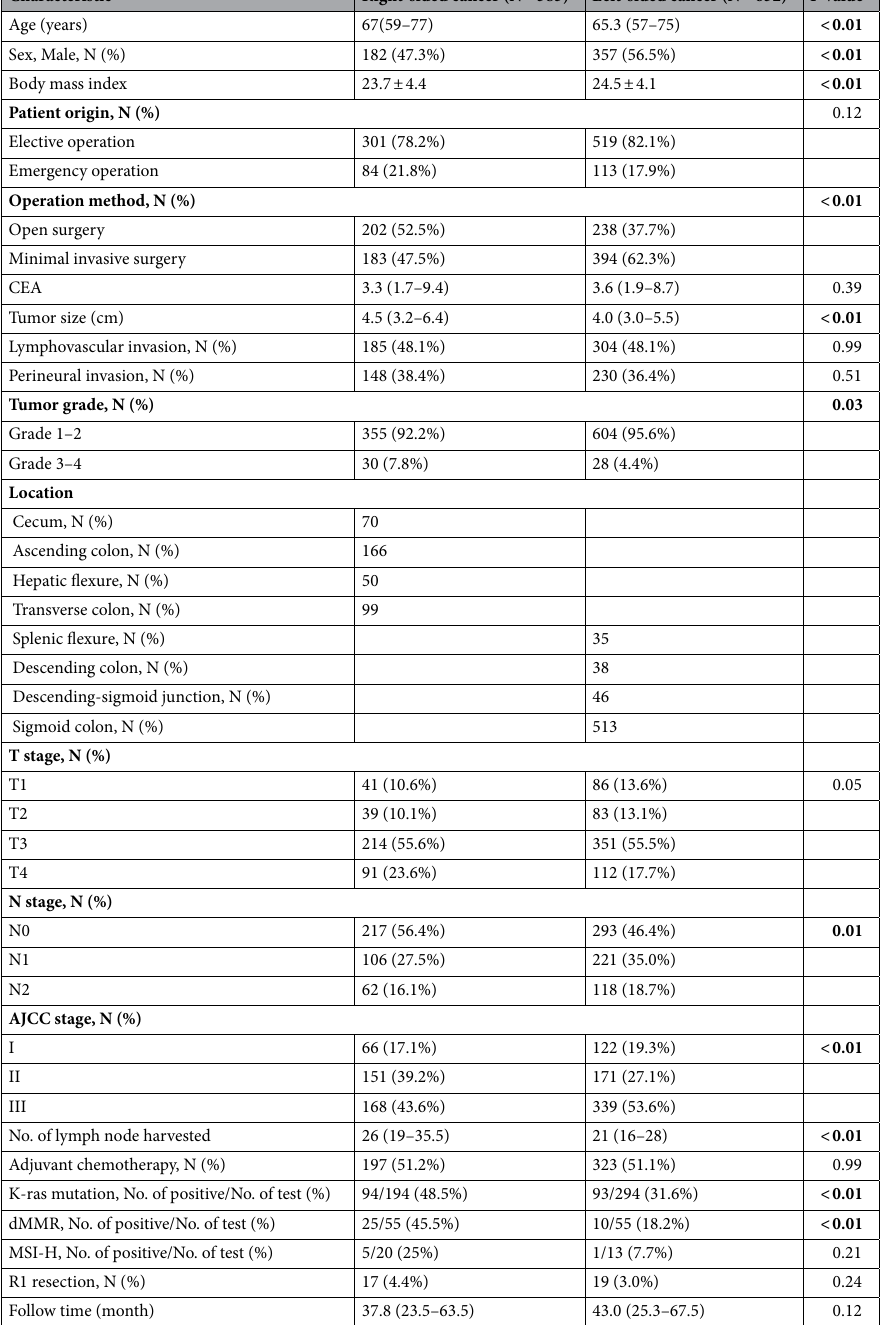
Table 1. Baseline characteristics of all patients. Significant values are in bold. CEA carcinoembryonic antigen, dMMR Deficient mismatch repair, MSI-H microsatellite